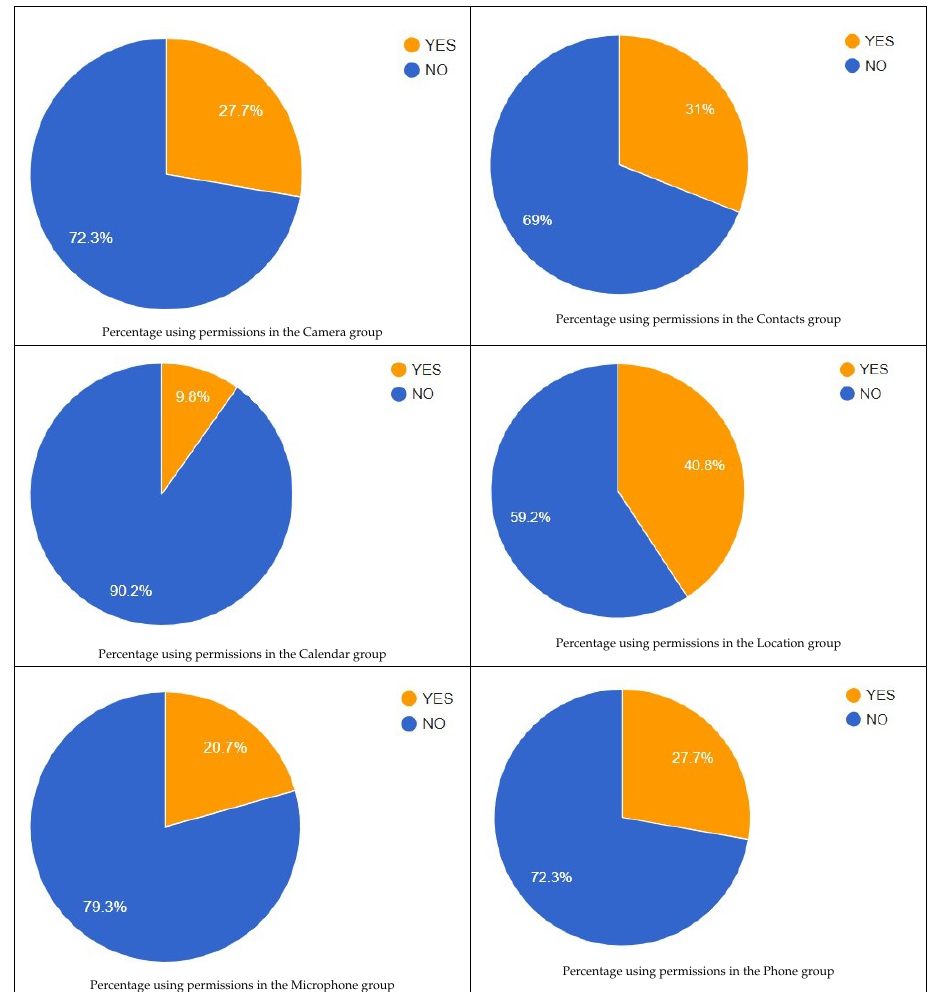
Figure 6. Example of the graphical information provided for the mobile applications permissions